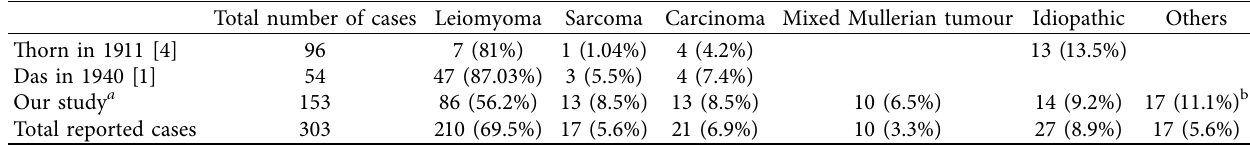
Table 1: Possible etiological factor of nonpuerperal uterine inversions.